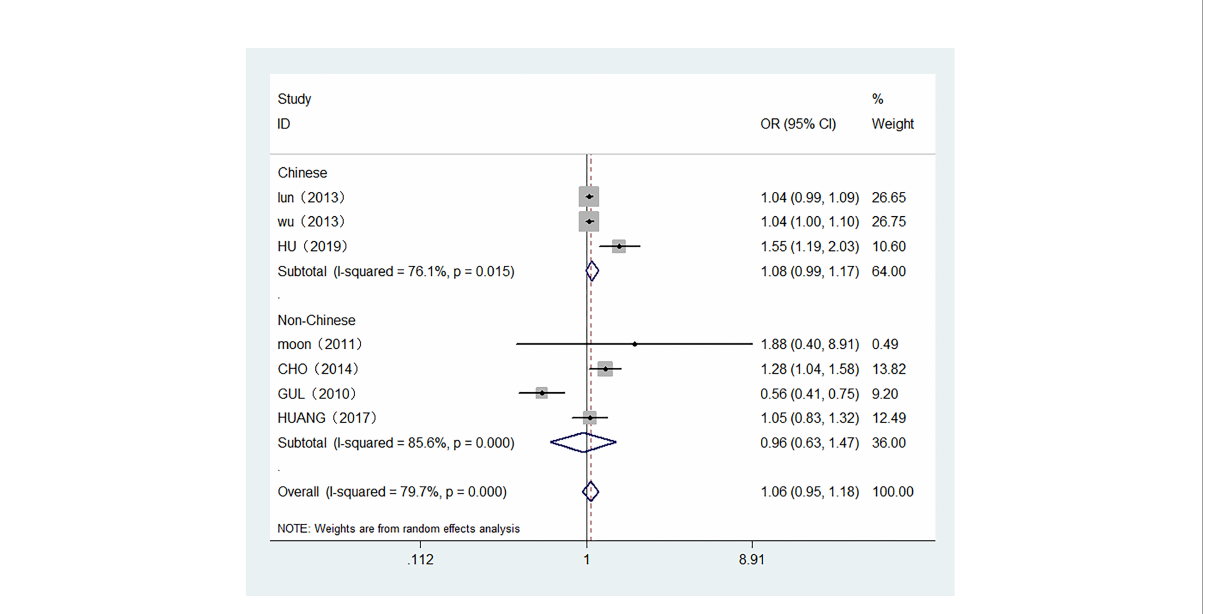
FIGURE 4 Forest plot of the risk of TC associated with FT4. Hollow diamonds represent pooled OR. Error bars indicate 95% CI.